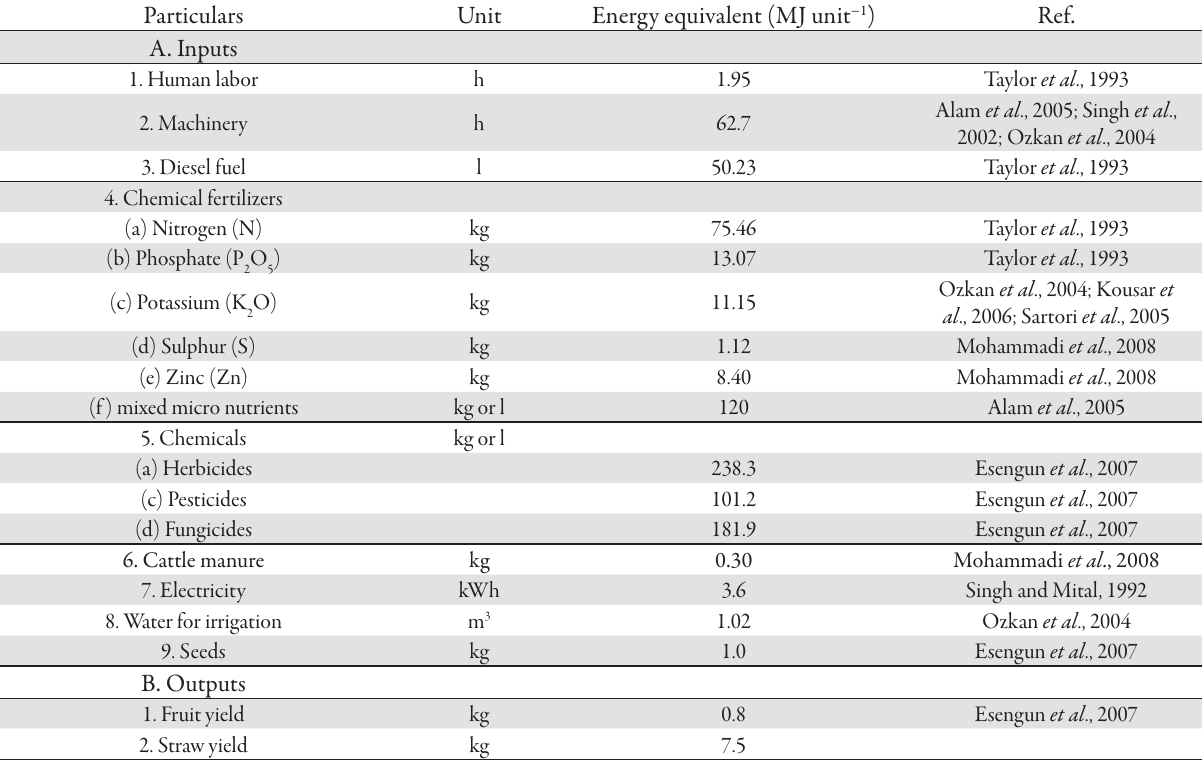
Tab. 1. Energy equivalent of inputs and outputs in tomato production